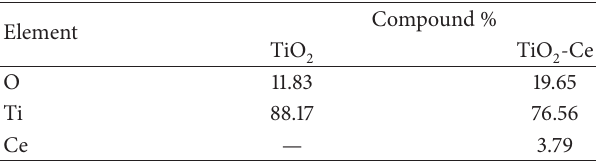
Table 2: Catalyst composition using EDX analysis of TiO -Ce catalyst. TiO 2